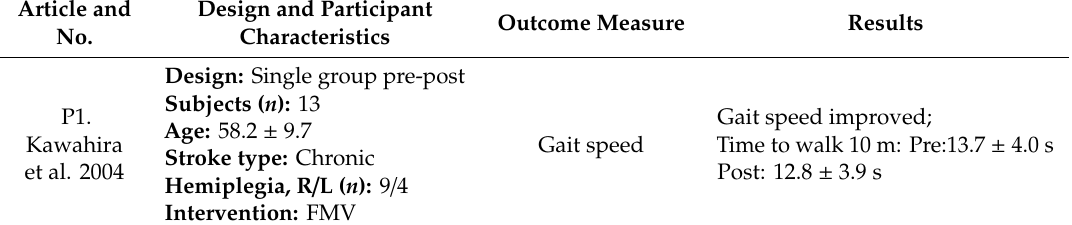
Table 1. Summary of the study designs, participant characteristics, outcome measures, and results. Article